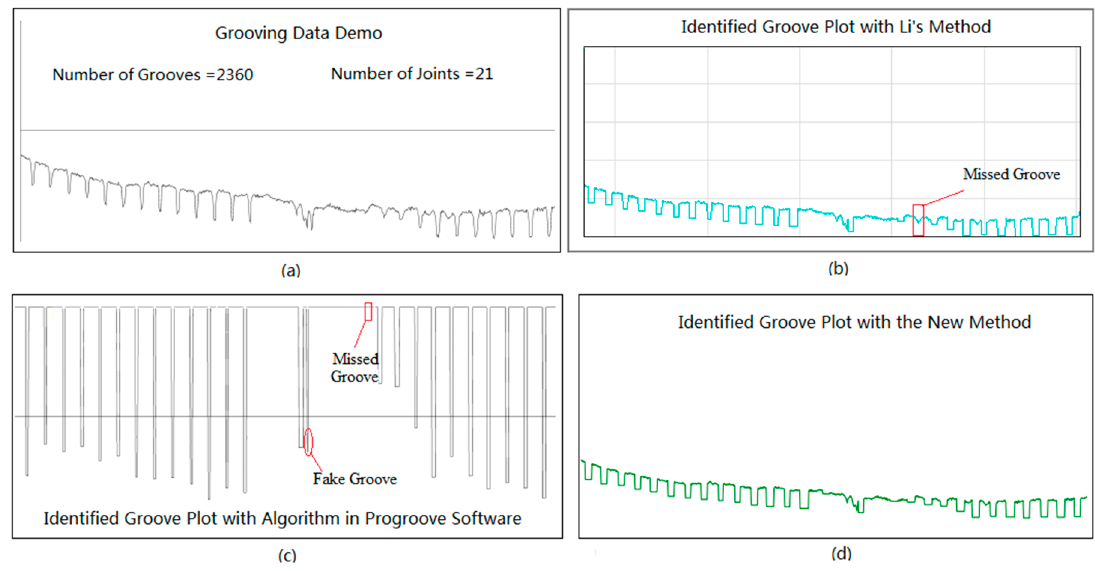
Figure 12. Identification result comparison: ( a ) Original grooving data; ( b ) Missed groove with Li’s Method; ( c ) Missed and fake groove with ProGroove software; ( d ) identified result with the new method.